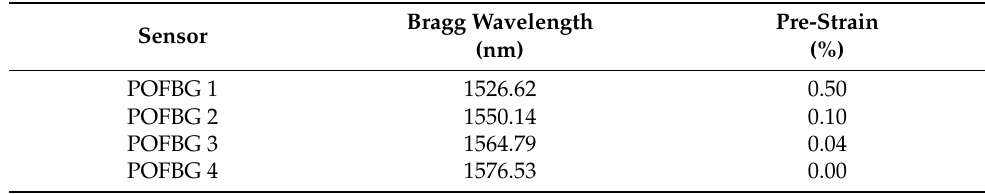
Table 1. Array of POFBG